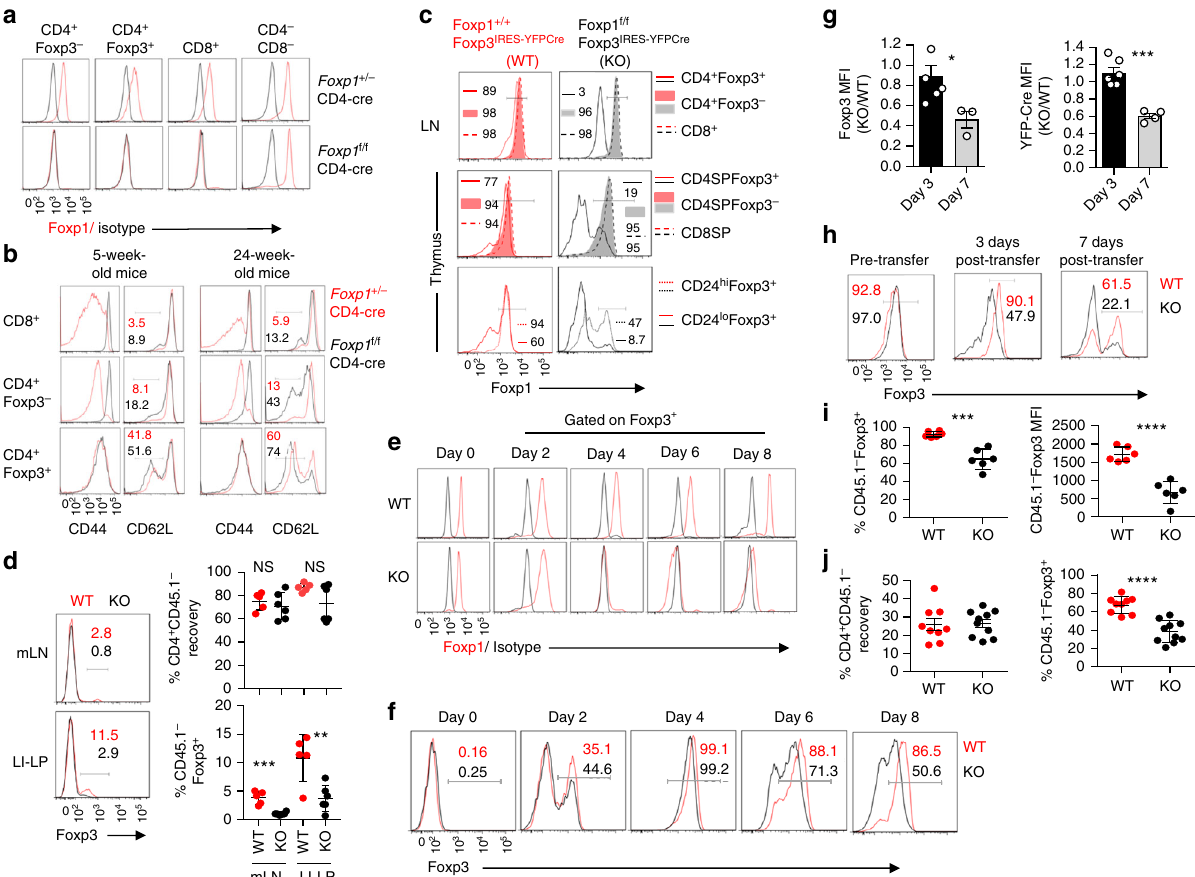
Fig. 1 Foxp1 is required to maintain stable expression of Foxp3 in iTreg cells. a Intracellular staining of Foxp1 to con fi rm T-cell-speci fi c deletion of Foxp1 in Foxp1 f/f CD4-Cre mice. b Expression of CD44 or CD62L in the indicated cell populations derived from lymph nodes of young and aged Foxp1 + / − CD4-Cre (red line) and Foxp1 f/f CD4-Cre (black line) mice. c Intracellular staining to con fi rm Treg-speci fi c deletion of Foxp1 in the lymph nodes (top), thymus (middle), and thymic CD24 hi Foxp3 + and CD24 lo Foxp3 + cells (bottom) of Foxp1 f/f Foxp3 IRES-YFP-Cre (KO) mice compared to littermate control Foxp1 + / + Foxp3 IRES-YFP-Cre mice (WT). d Representative FACS plots and quanti fi cation of percentage of in vivo iTreg conversion within CD45.2 + compartment, 2 months after adoptive transfer of Tnv cells isolated from WT or KO mice into RAG1 − / − host mice. e Foxp1 expression status within live CD4 + Foxp3 + in vitro-generated iTreg cells originating from WT- or KO-derived Tnv cells after TGF- β treatment for the indicated number of days. IgG staining is shown as isotype control. f Status of Foxp3 expression within CD4 + live cell population in the same iTreg assay shown in e . g Mean fl uorescent intensity (MFI) changes for Foxp3 and YFP-Cre in KO-derived iTreg cells relative to WT at the indicated time points. * P < 0.05, *** P < 0.0001 (Student ’ s t test, error bars, s.e.m). h WT- or KO-derived iTreg cells were sorted at high purity after 3 days of TGF- β treatment and co-transferred in RAG1 − / − hosts along with compartment from lymph nodes of recipient mice at the indicated time points are shown. i Percentage of cells retaining Foxp3 (left) and its expression per cell depicted by MFI (right) after 3 days post-transfer. j Percentage of CD45.2 + cells recovered (left) and retaining Foxp3 (right), 7 days post-transfer. Each fi lled circle represents a single RAG1 − / − recipient mouse analyzed. Data are representative of 2 – 5 independent experiments. * P < 0.05, ** P < 0.01, *** P